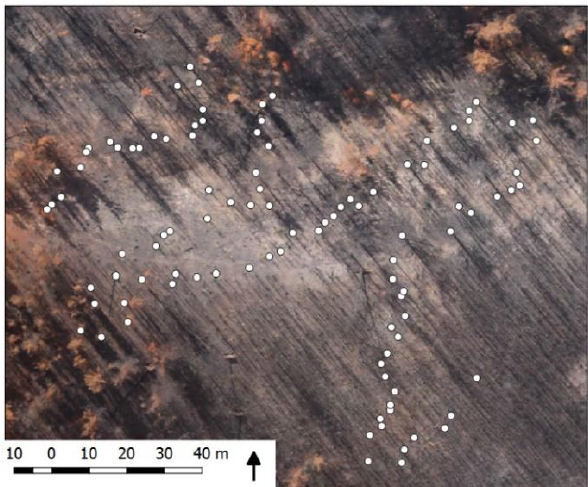
Figure 2. The UAV-based orthomosaic. The positions of the sampled trees (n=100) are shown in